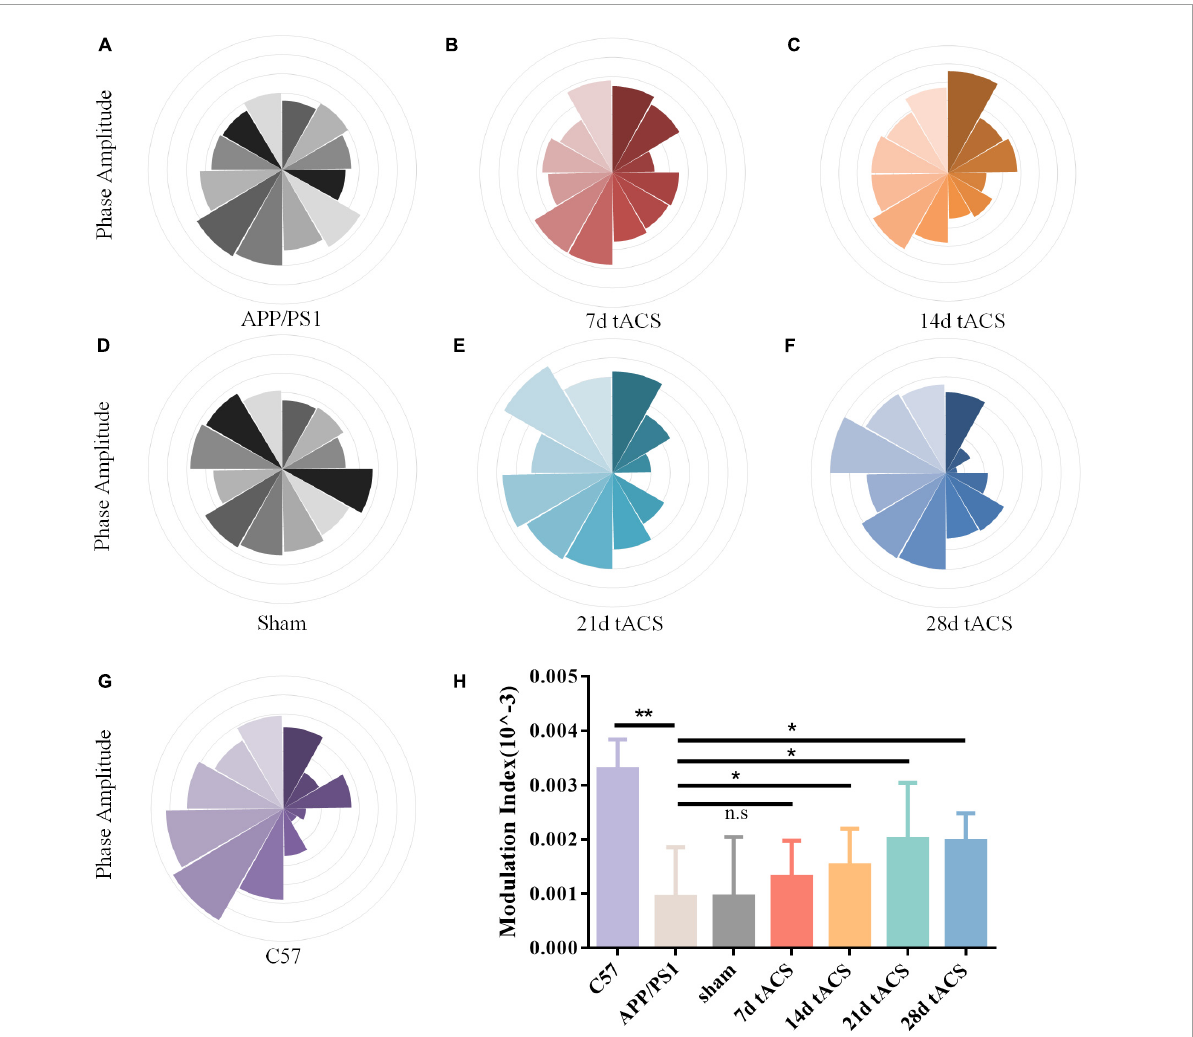
FIGURE6 (A) APP/PS1 group MI spectrum, (B) 21 days APP/PS1 group MI spectrum, (C) 28 days APP/PS1 group MI spectrum, (D) sham group MI spectrum, (E) 21 days APP/PS1 group MI spectrum, (F) 28 days APP/PS1 group MI spectrum, (G) C57 group MI spectrum, (H) MI of CFC between different groups, * indicates P < 0.05, ** indicates P < 0.01. n = 5 mice for each group. The MI index of mice in C57 group was 0.0033 ± 0.0006, the MI index of mice in APP/PS1 group was 0.0009 ± 0.0009, the MI index of mice in sham group was 0.001 ± 0.0011, the MI index of mice in 7